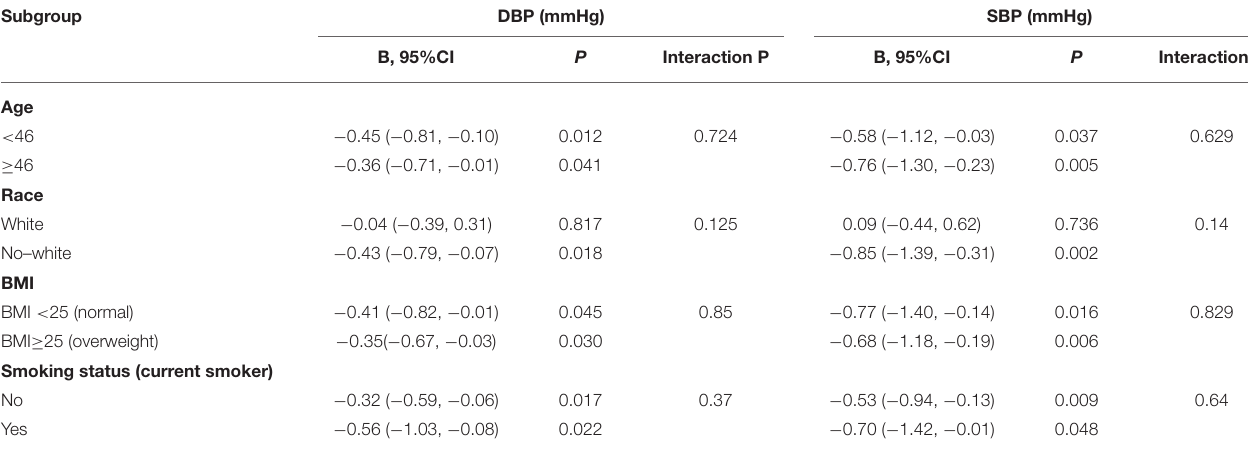
TABLE 4 | Multiple linear regression analysis for relationship between DDE fiber from grains and blood pressure stratified by age, race, BMI and current smoker prespectively.